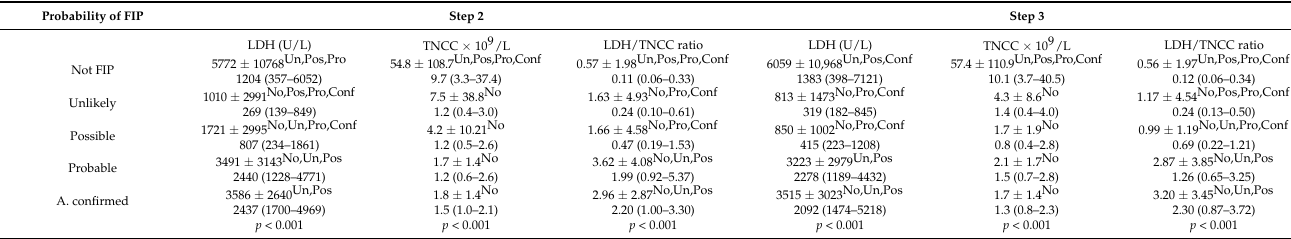
Table 6. Comparison of TNCC, LDH, and LDH/TNCC ratio in effusions classified in terms of probability of FIP based on physicochemical and cytological findings (step 2) or based also on additional clinical and laboratory data (step 3). Results are expressed as mean ± standard deviation, median and between parenthesis I–III inter-quartile ranges.